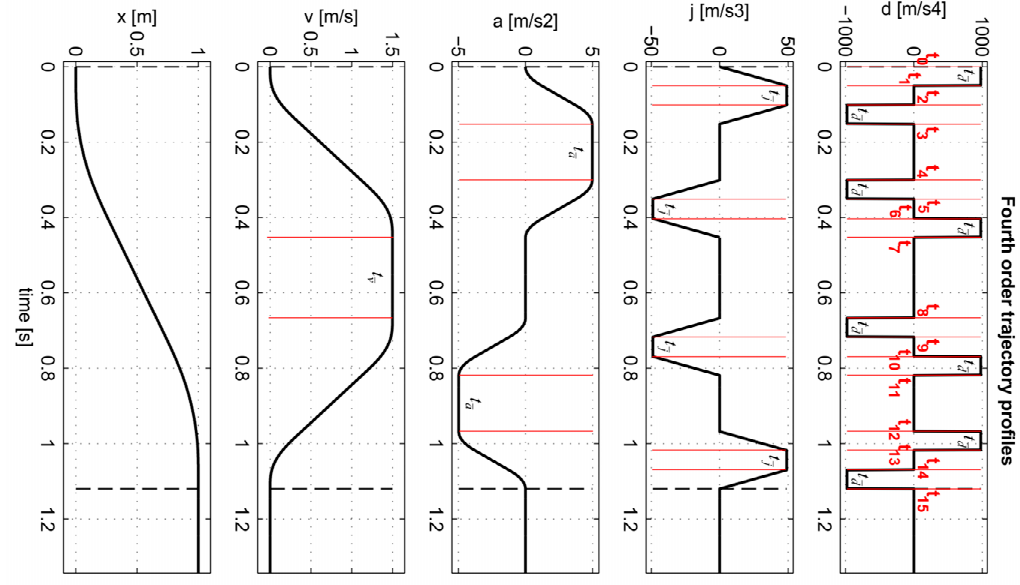
Figure 5. Fourth order trajectory profiles in point-to-point movement with profile times shown.